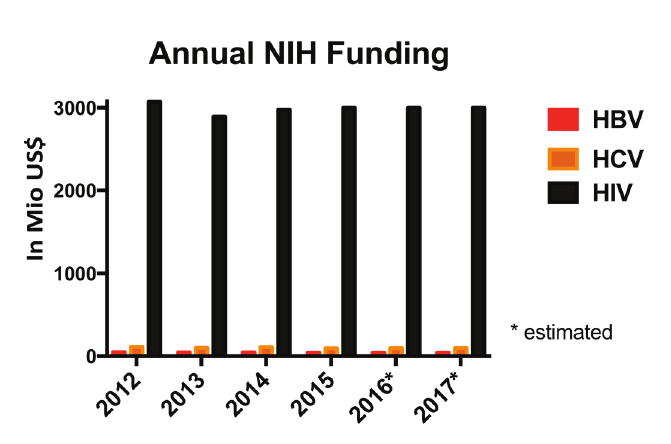
Figure 1: NIH research funding for HCV, HBV and HIV infection. Annual report of NIH funding, expressed as millions of dollars,(US) for research related to HIV (black bars), HCV (orange bars) and HBV (red bars) from 2012 to